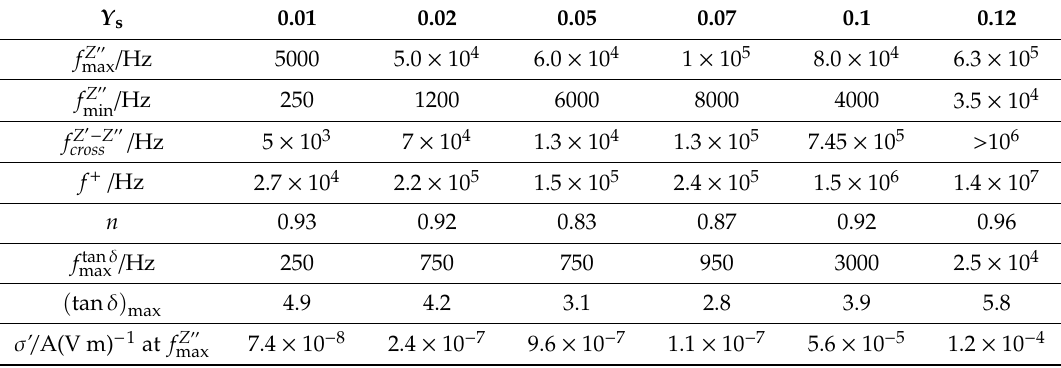
Table A1. Characteristic frequencies in system PEO + LiClO 4 at 25 ◦ C.